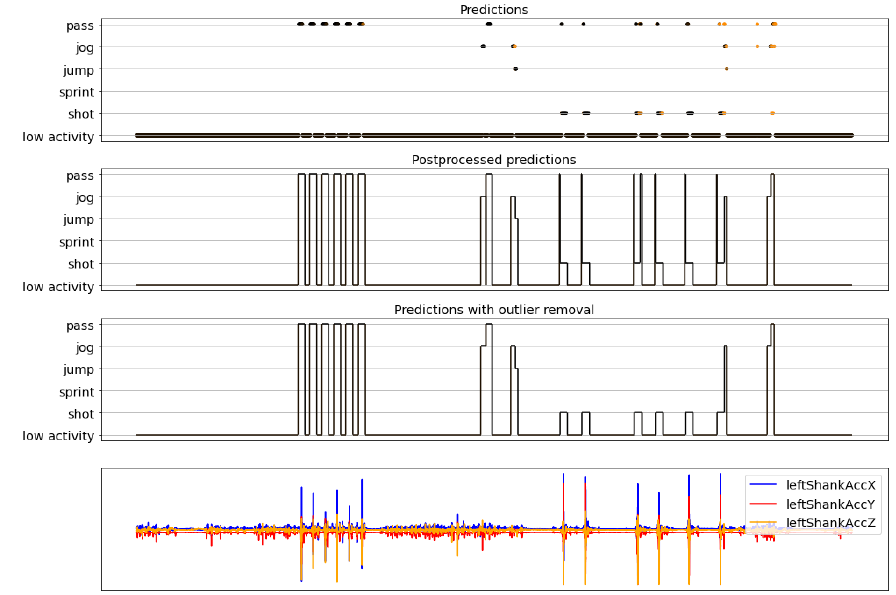
Figure 21. Example 3 of final results. True labels: 6 jumps-passes followed by 6 shots. Fast, unplanned movements are identified before and after the